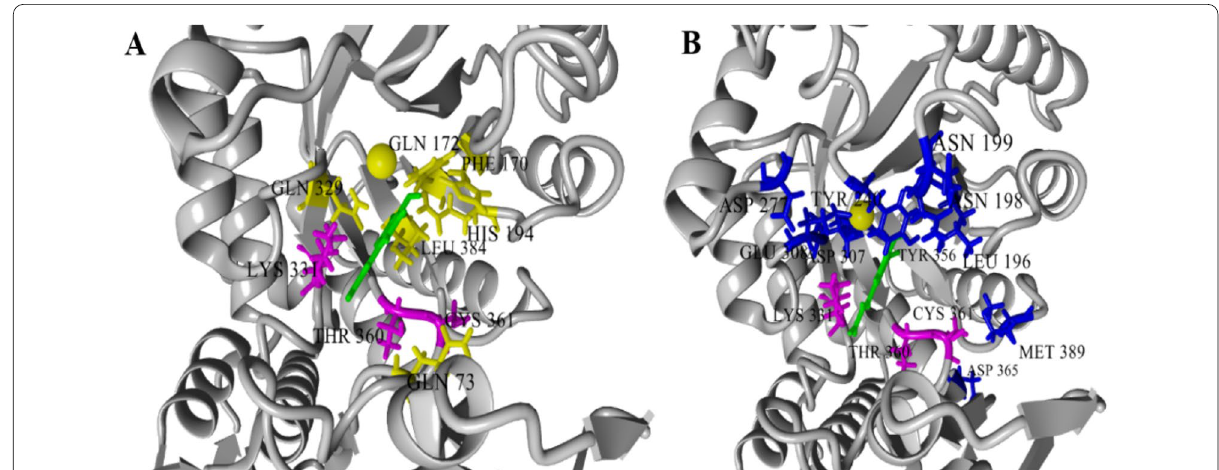
Fig. 1 Ec MAL residues chosen for saturation mutagenesis marked in the homology model built by the crystal structure of MAL (PDB: 1KKR). A Active site mutation sites (yellow) selected on the basis of induced fit docking of amine 1 (green). B Residues surrounding the substrate access tunnel likewise chosen for mutagenesis (blue). The above residues were obtained through the molecular docking of Yasara and the channel recognition function of CAVER 3.0,